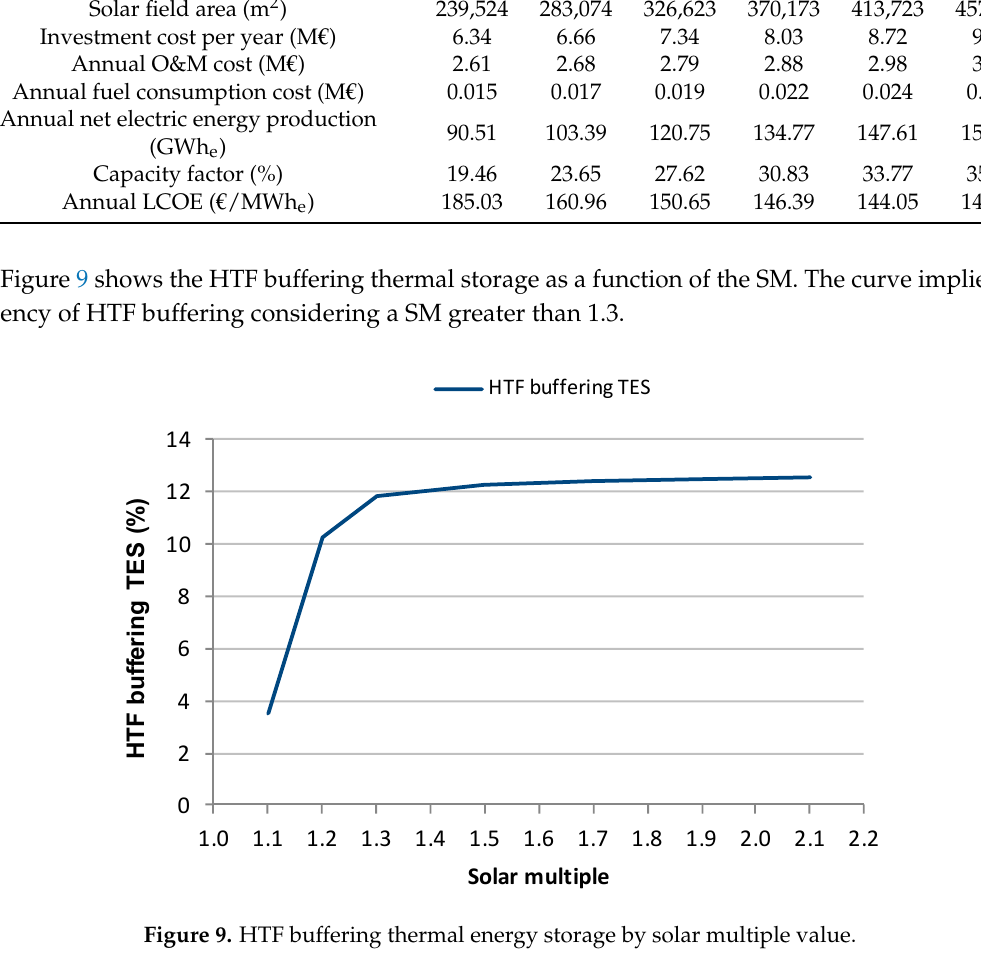
Table 6. Economic results for a 50-MW e PT power plant with heat transfer fluid (HTF) buffering thermal storage as a function of the solar multiple. Solar Multiple Value